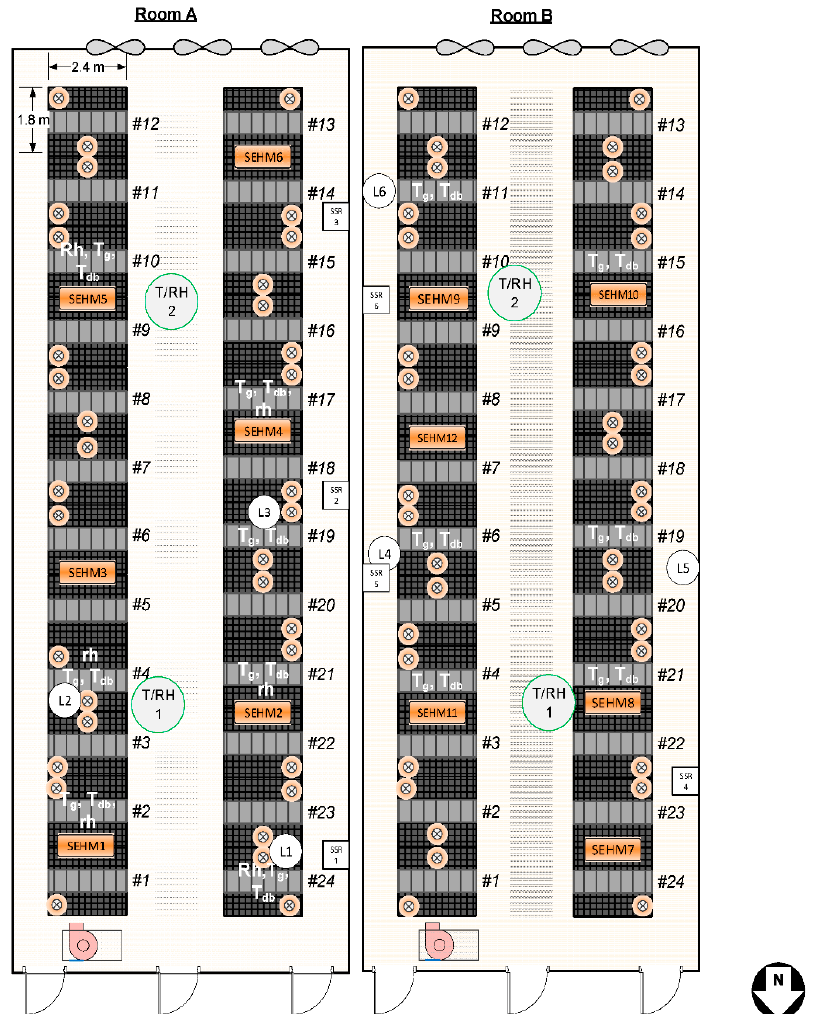
Figure 2. Thermal Environment Sensor Array (TESA) for microclimate instrumentation. Sensors are labeled: (A) black globe temperature (BGT), (B) dry-bulb temperature (DBT), (C) relative humidity (RH).